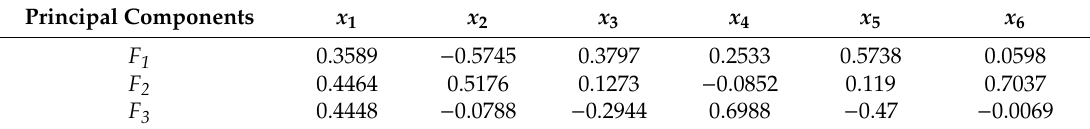
Table 10. Eigenvectors of the correlation coe ffi cient matrix.